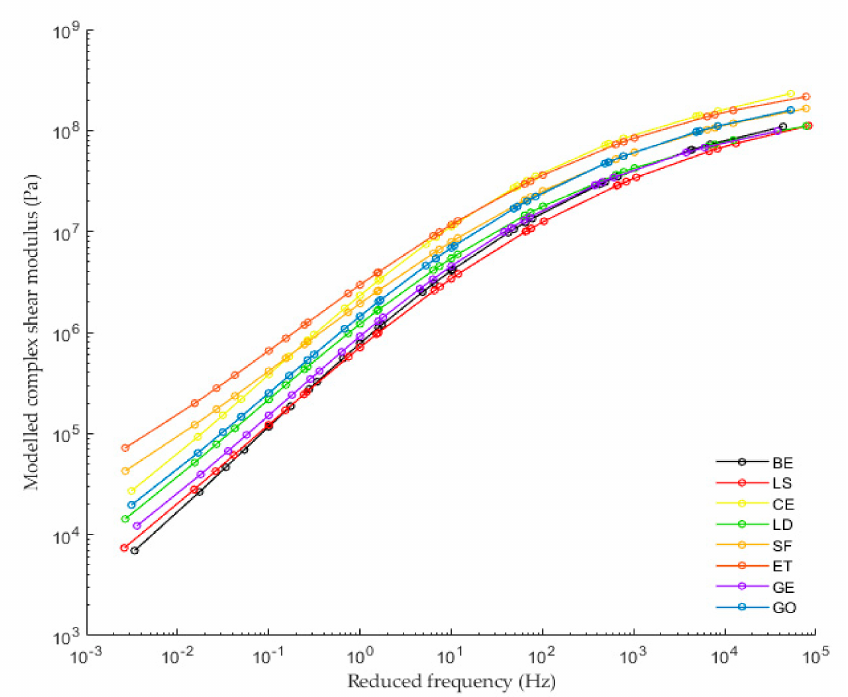
Figure 7. Modeled complex master curves of Bitumen Emulsion (BE) and CBE mastic at a reference temperature of 20 ◦